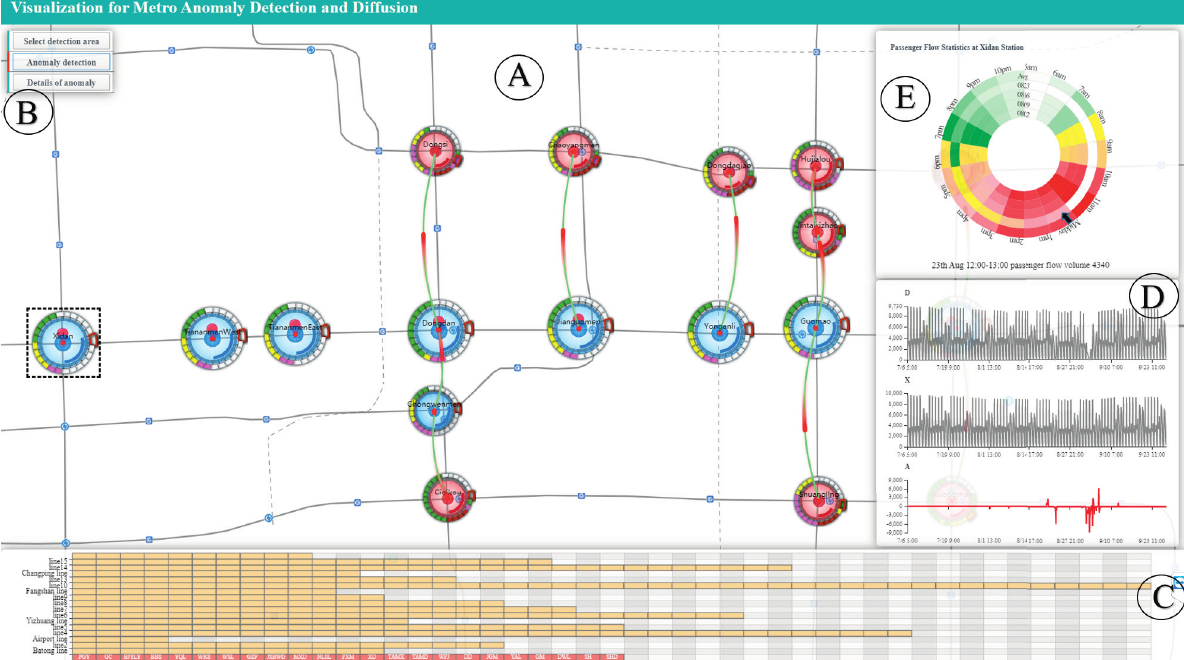
Figure 2: System interface. (a) Anomaly diffusion view: display anomalies and demonstrate the spatiotemporal law of anomalies. (b) Interaction panel: provide some interactive functionality. (c) Overview view: grasp the running status of all stations. (d) Matrix view: show the result of anomaly detection. (e) Verification view: show passenger flow changes on the day compared with historical passenger flow.